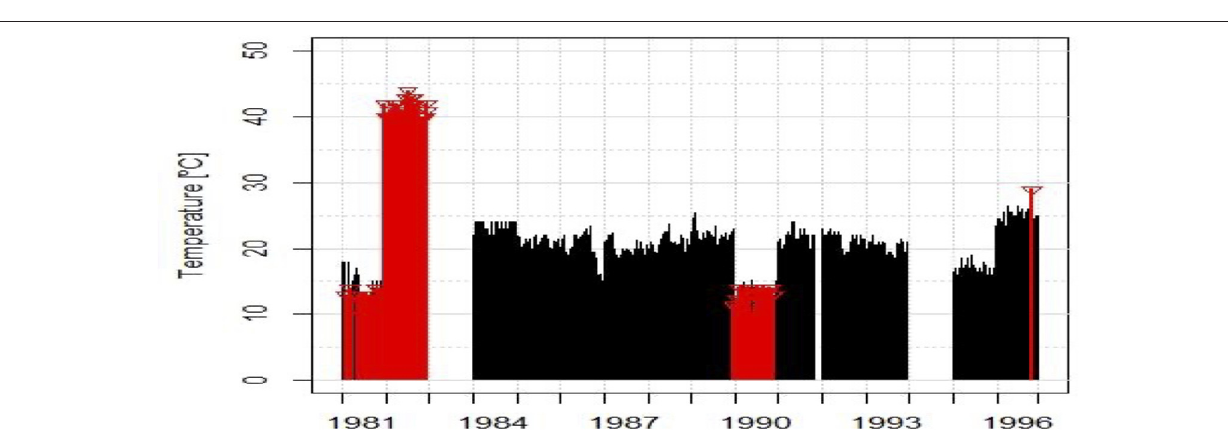
Frontiers in Climate |